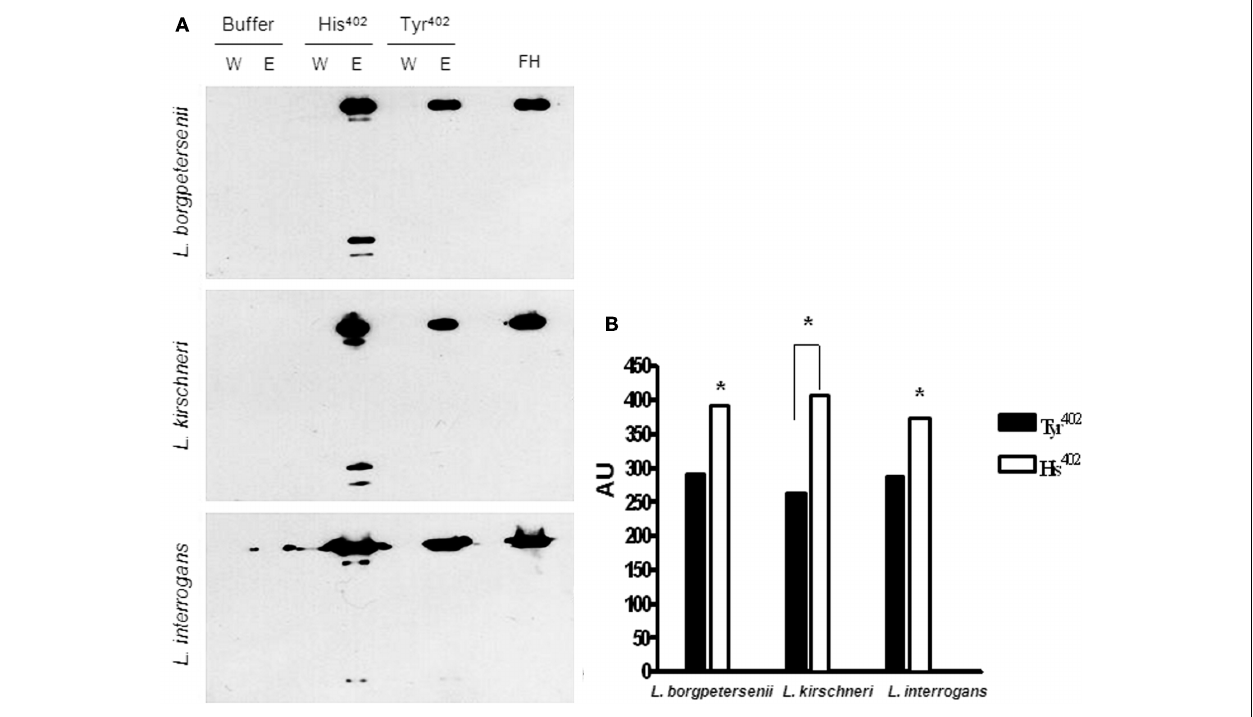
wash; (E) aliquots of the eluted fractions; purified FH (100ng) was included as a positive control. (B) Quantification of the FH bands in part (A) as described in Section “Materials and Methods.” Data are presented as arbitrary units (AU). Both variants of FH were purified only by affinity